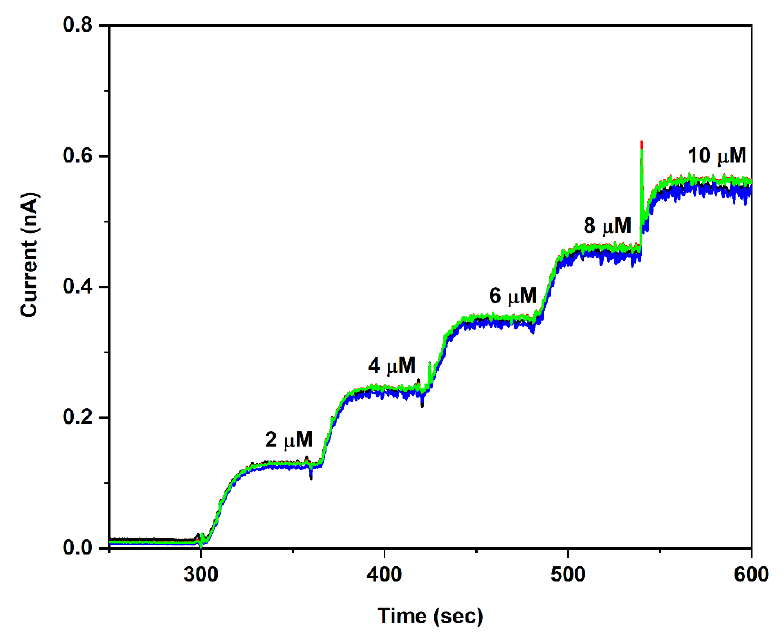
Figure 2. Overlay of amperometry calibration curves recorded from the four Pt UMEs within a Si probe. The calibration data of the four UMEs 1 to 4 are shown in black, red, blue, and green curves. The CV cleaned UMEs were biased at + 0.7 V vs. Ag/AgCl reference. The solution was stirred at 200 rpm and maintained at 37 °C.